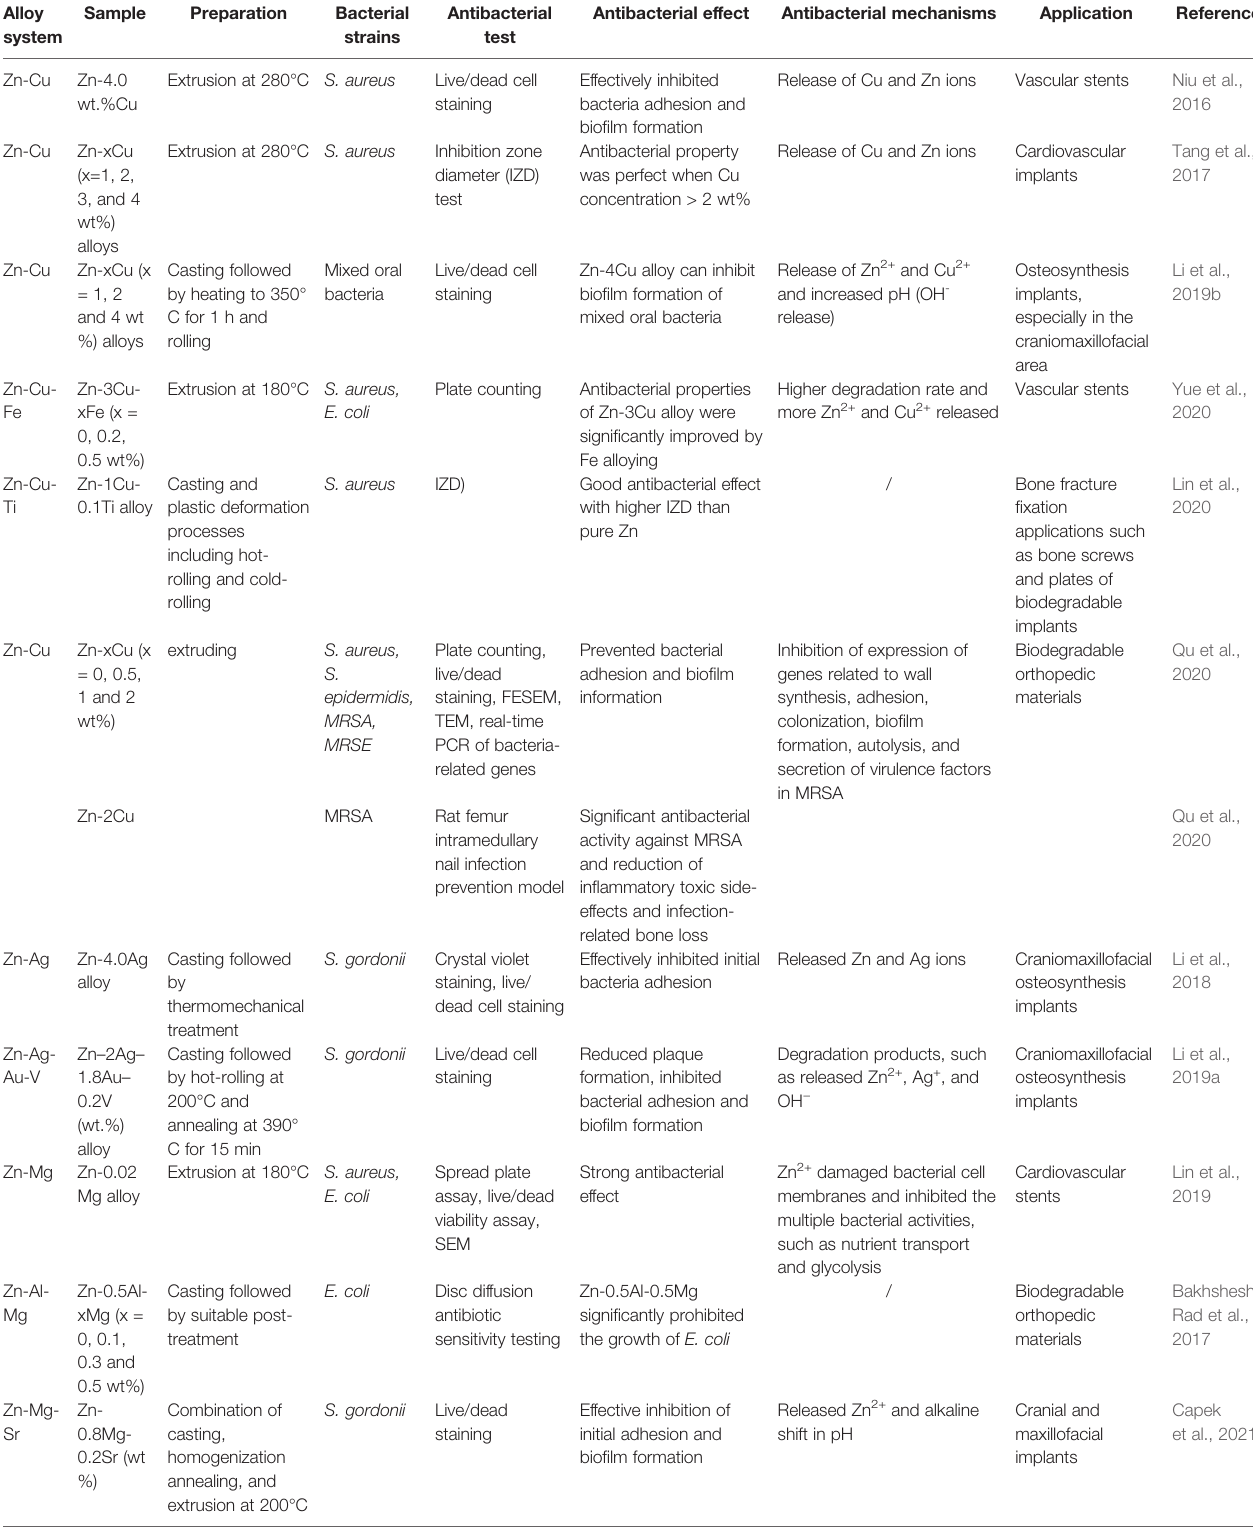
TABLE 4 | Engineered zinc alloys with antibacterial properties. Alloy system